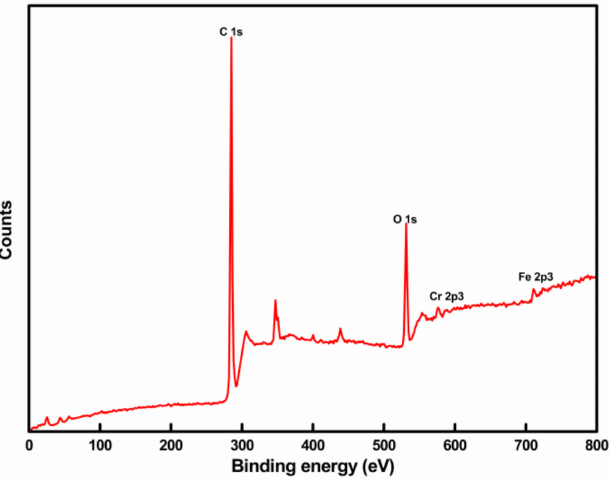
Figure 4. The XPS survey spectra recorded from a thin film magnetite on SS